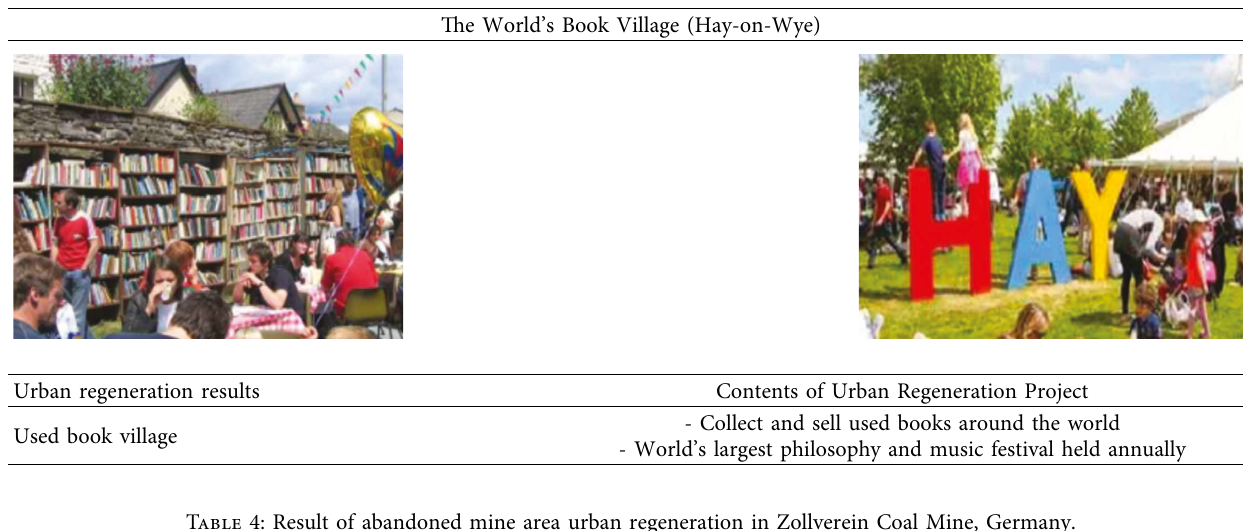
Table 3: Result of urban regeneration for Hay-on-Wye Project in the United Kingdom.